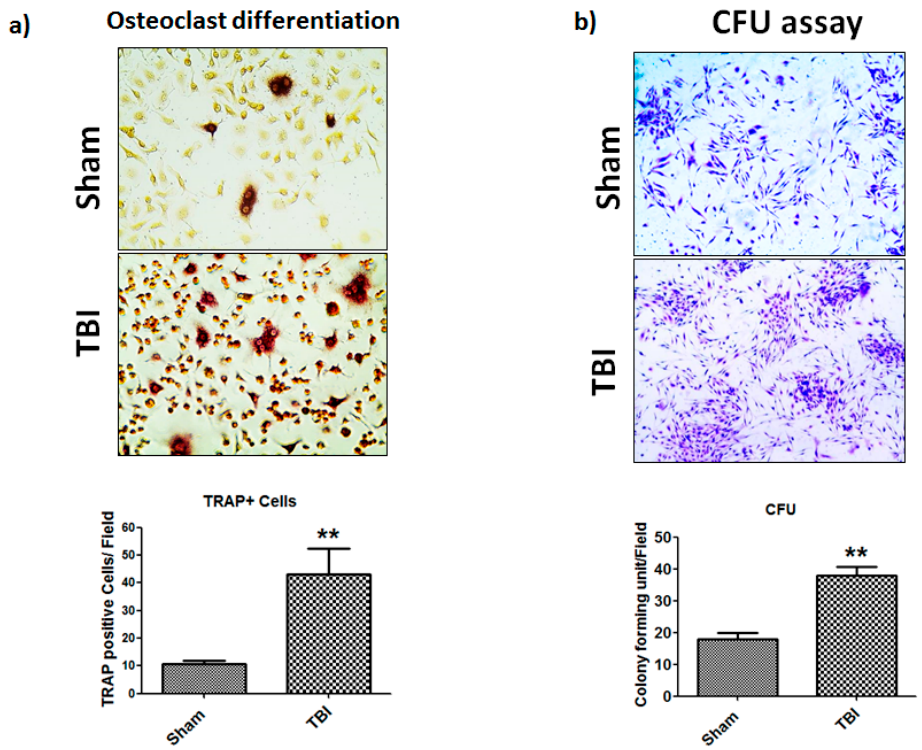
Figure 5. Effect of TBI on osteoclast differentiation and colony forming unit (CFU) on bone marrow cells. ( a ) Mouse primary bone marrow cells were cultured with RANKL (100 ng/mL) and M-CSF (30 ng/mL) for 4 days followed by TRAP staining. After TRAP staining, TRAP + multinuclear cells (TRAP + MNCs) with more than three nuclei were scored as osteoclasts. ( b ) Colony forming assay was performed, stained with crystal violet, and colonies were counted * p < 0.05 and ** p < 0.01 compared with vehicle-treated control.